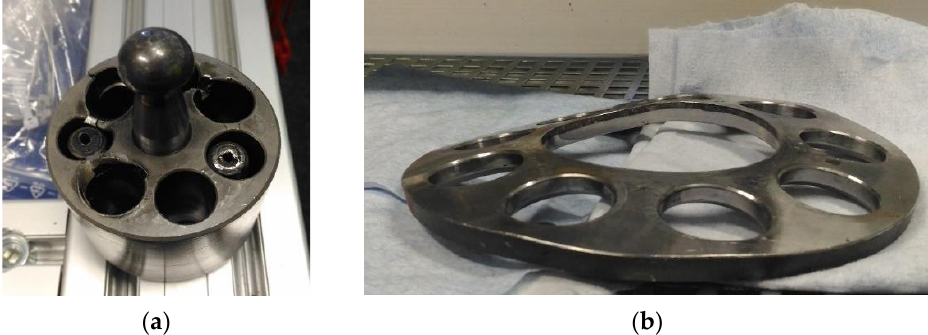
Figure 1. The damaged parts of an axial piston pump: ( a ) cylinder block with pistons, ( b ) slipper- retainer.